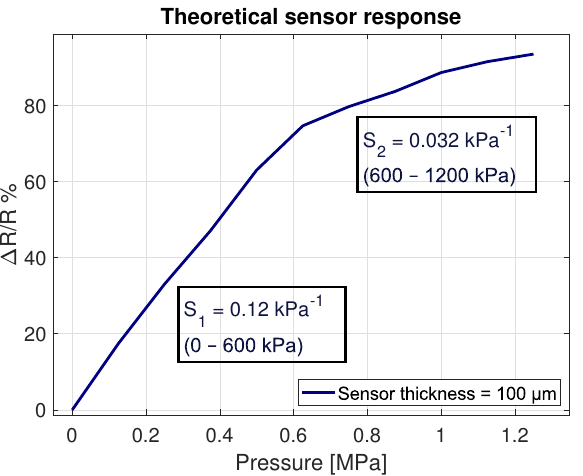
Figure 6. The theoretical sensor response from 2D sensor model. Different layer thicknesses (50–700 µ m) were simulated to find the effect on the sensor response. Conductivity in the thin sensing layers are expected to change rapidly, as the layer is in the same order of magnitude as the lengths of the CNTs. With increasing thickness, it takes relatively more nanoparticles to overcome the longer paths between the electrodes.